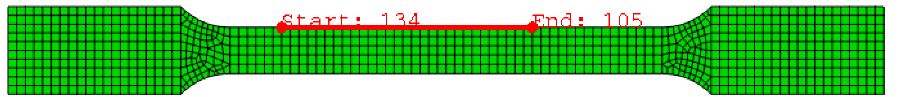
Figure 14. Path reflecting the extensometer.